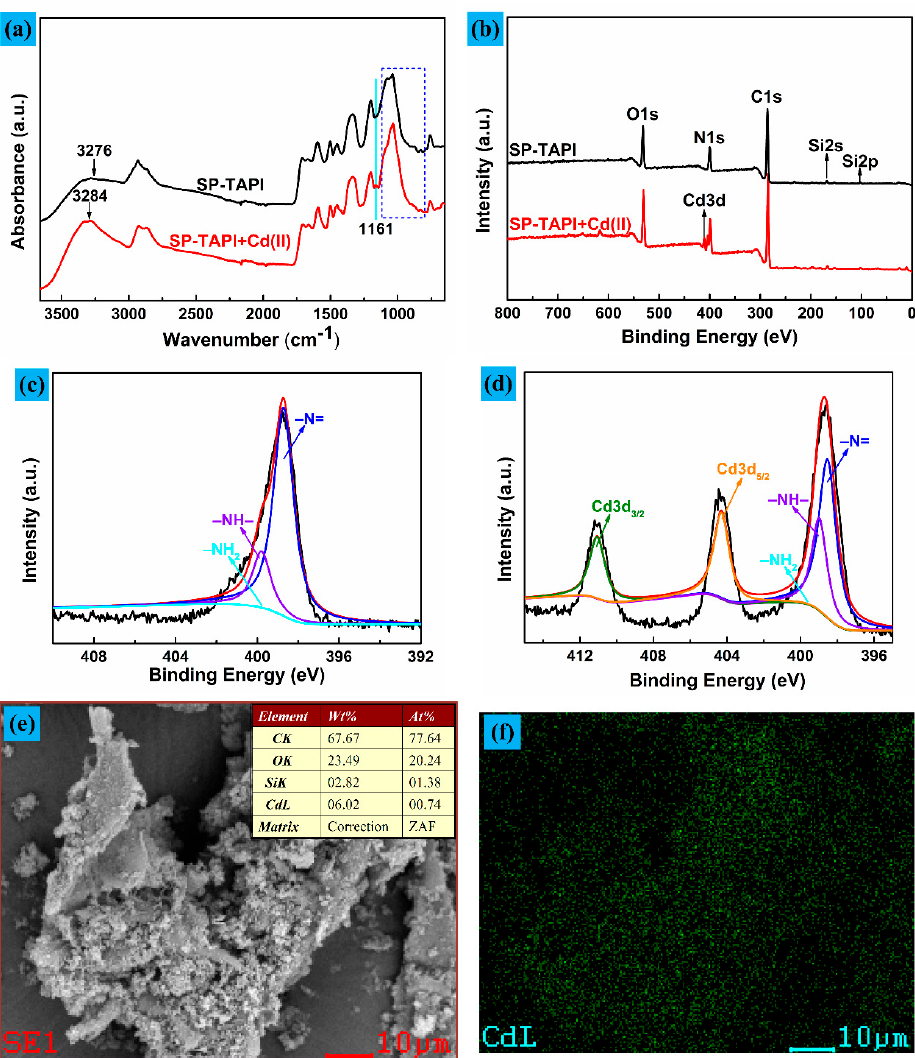
Figure 5. ( a ) FTIR and ( b ) XPS spectra of SP-TAPI before and after Cd(II) adsorption. ( c ) N 1s and ( d ) Cd 3d XPS spectra of the SP-TAPI composites before and after Cd(II) adsorption. ( e ) SEM image and ( f ) EDS spectrum of SP-TAPI after Cd(II) adsorption.